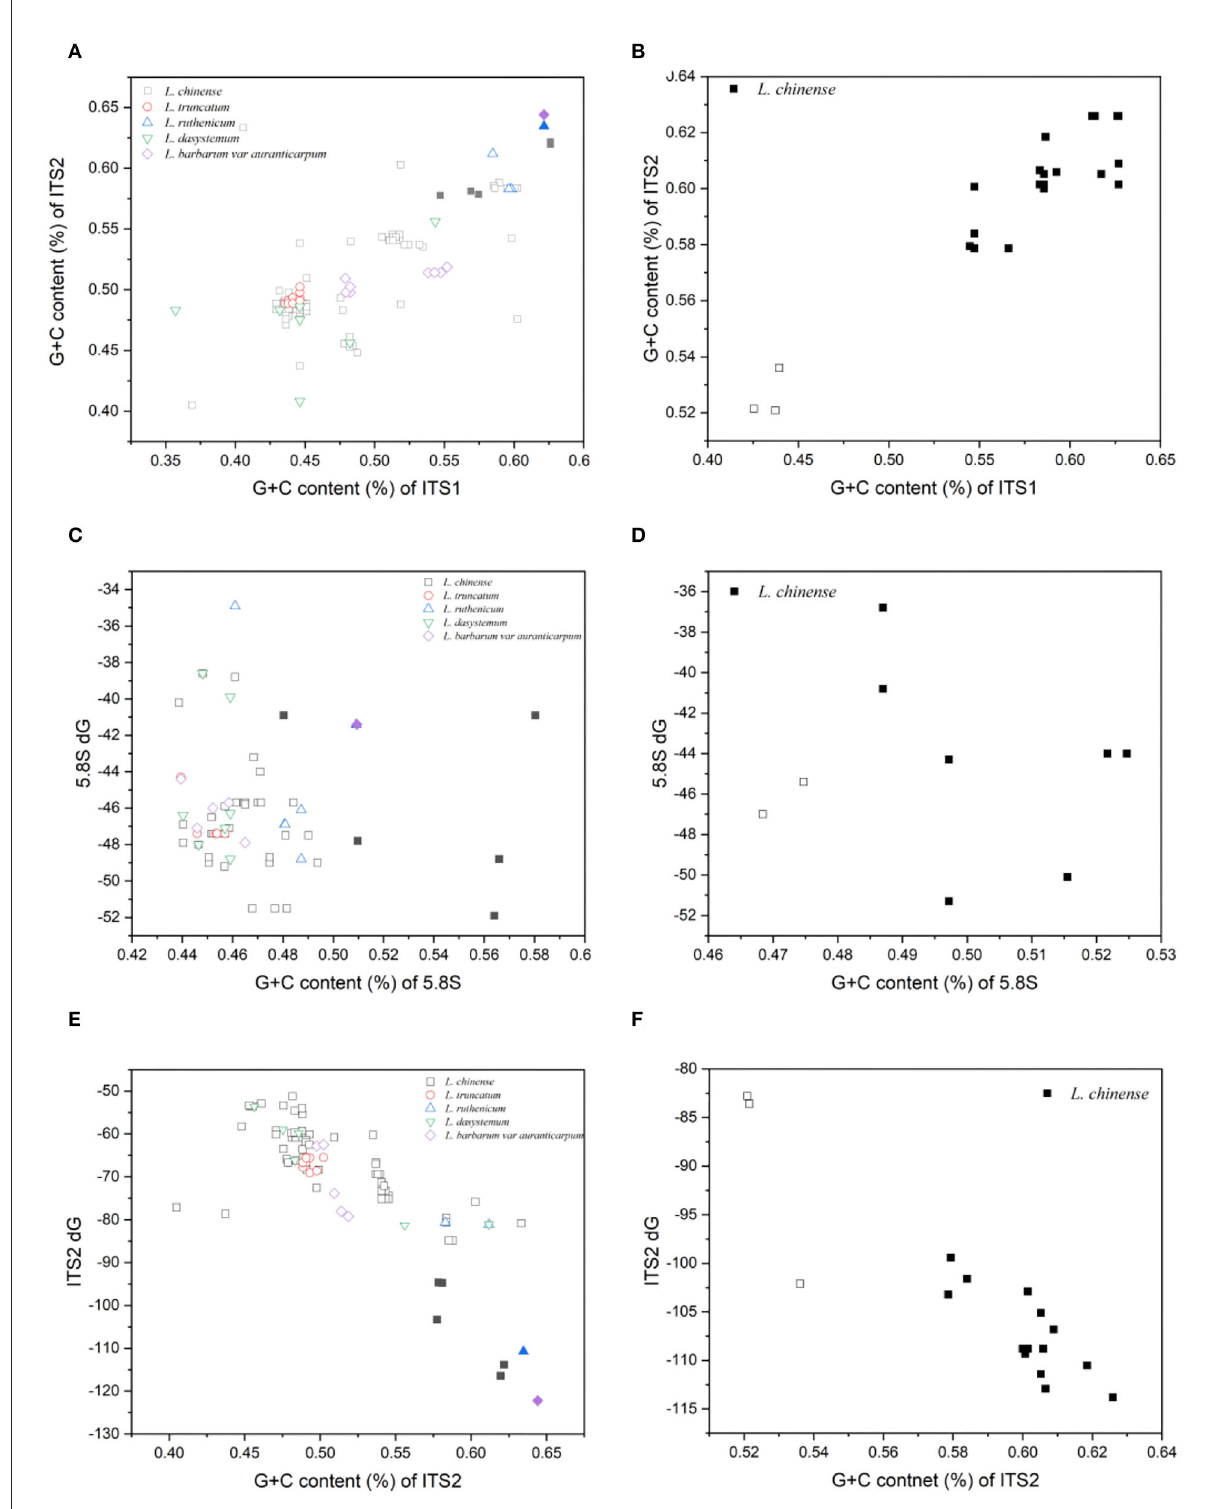
FIGURE1 Plot of the G + C content of all paralogues obtained from five Lycium species. (A,B) ITS1 vs. ITS2. (C,D) 5.8S vs. the minimum free energy ( 1 G at 37 ◦ C) of the secondary structure of 5.8S. (E,F) ITS2 vs. the minimum free energy ( 1 G at 37 ◦ C) of the secondary structure of ITS2. The left panel shows the results for primer pair ITS1/ITS4, and the right panel shows those for primer pair P1/P2. Shaded symbols indicate putative functional sequences and blank symbols indicate putative